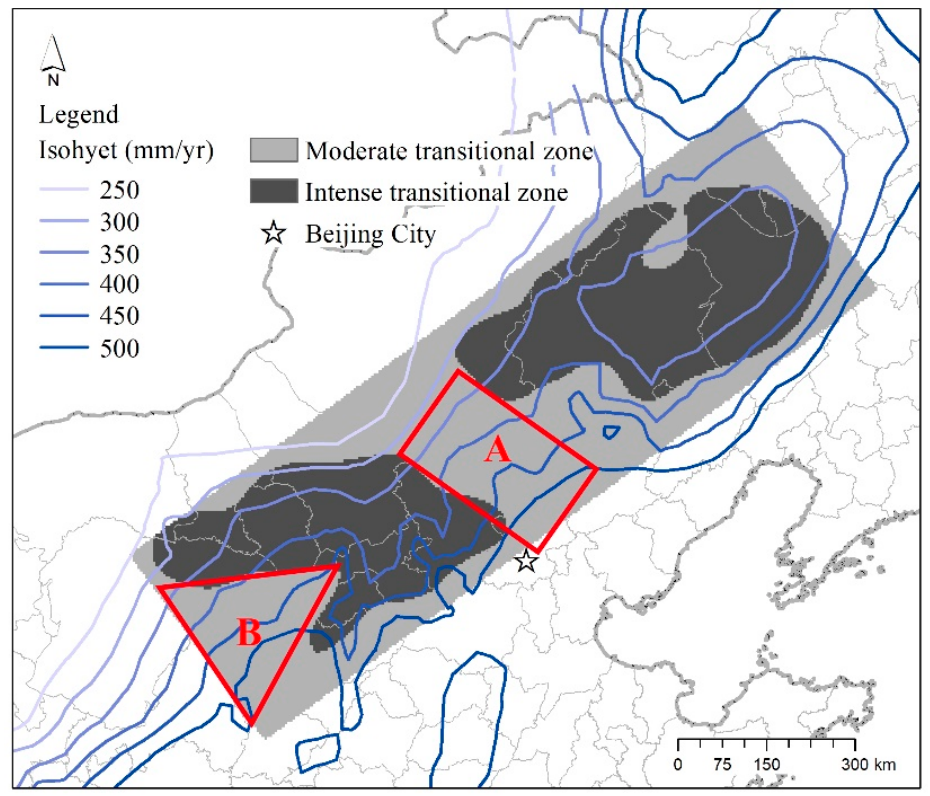
Figure 7. Comparison between the agro-pastoral transitional zone (APTZ) delineated using the threshold precipitation method and using the spatial continuous wavelet transform (SCWT) method with normalized difference vegetation index (NDVI). (Region A and B are representing the main differences between the two methods.).